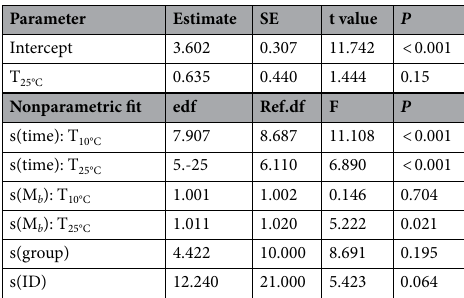
Parameter Estimate SE t value P Intercept 3.602